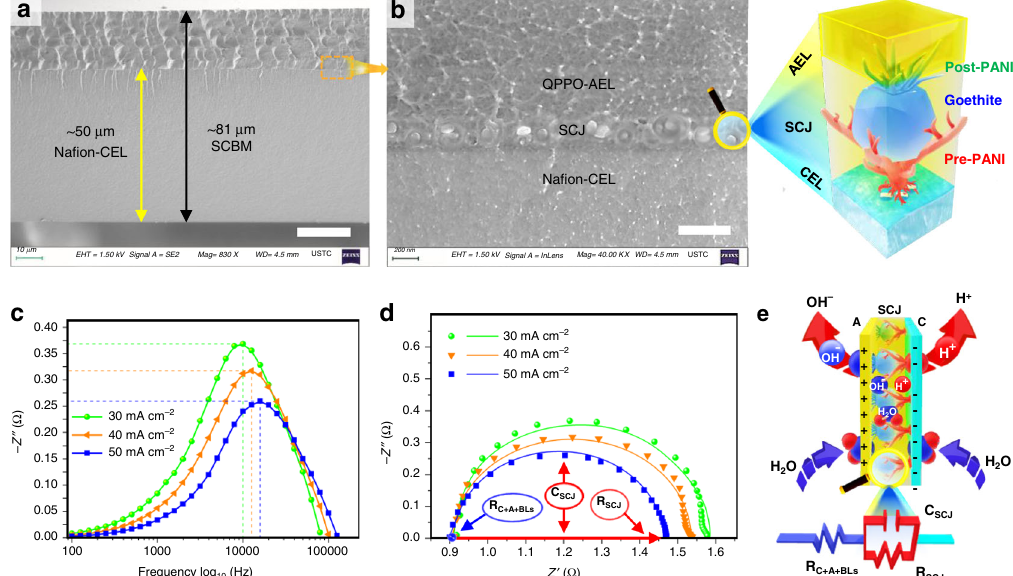
Fig. 4 Physico-electrochemical analysis of the SCBMs. a SEM cross-sectional image showing a uni fi ed SCBM comprising ~50- µ m-thick Na fi on-CEL, ~31- µ m-thick QPPO-AEL, and a clear junction. The scale bar corresponds to 20 μ m. b A magni fi ed SEM cross-sectional image and adjacent illustration exhibiting shielded catalyst nanoparticles at the C/AEL interface. The scale bar is equal to 400nm. c The EIS Bode curves indicating their shift towards lower impedance and higher frequency values, which preliminary predict a decrease in water dissociation reaction resistance and improved junction hydration at larger current densities. d The EIS Nyquist plots, where shortened diameters of the semicircles predicting decreased charge transfer or water dissociation resistance at increased current densities 6 . The measured EIS data (symbols) was simulated with an EEC model (solid lines) to interpret the exact response of the membrane and SCJ. e The illustration representing the membrane and a best-suited Randles circuit model ( fi tting accuracy >97% and χ 2 value <10 − 4 ), R C + A + BLs (C SCJ R SCJ ). Here, the resistor R C + A + BLs , the capacitor C SCJ and the resistor R SCJ representing the cumulative CEL-AEL-BLs resistance, the junction capacitance and junction resistance 7